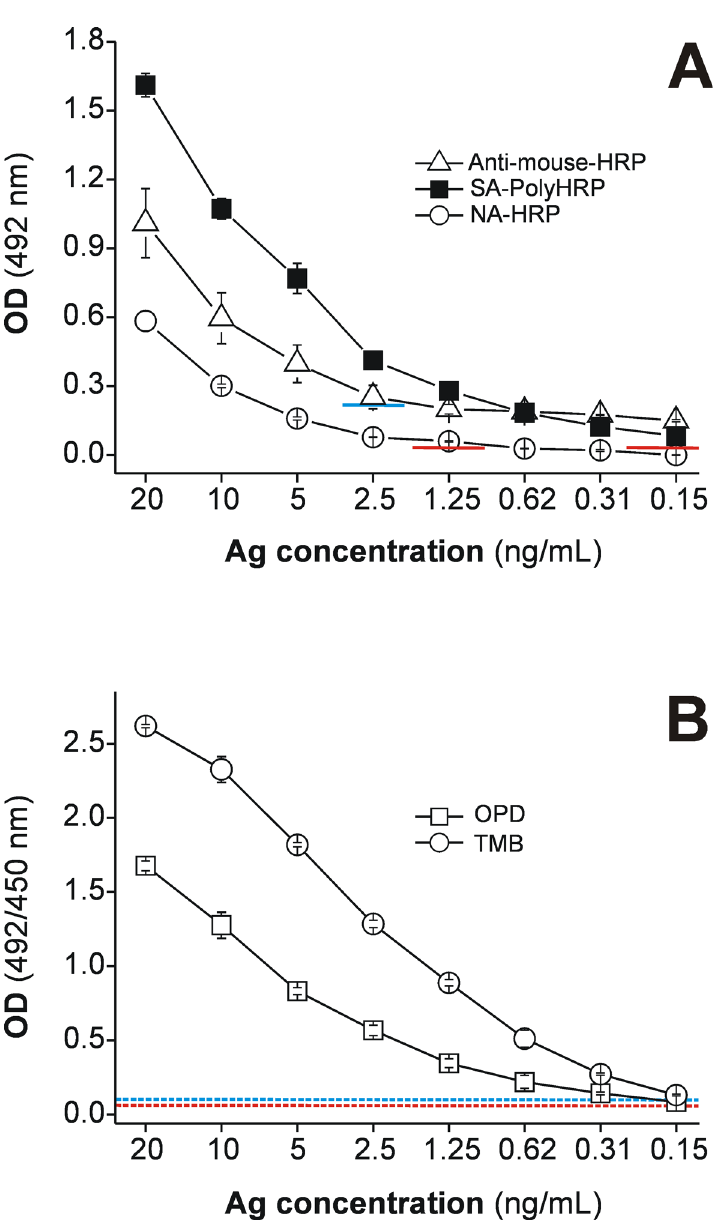
Fig 3. Detectability of rapid MM3-COPRO ELISA performed with three HRP-labeled secondary reagents and two HRP substrates. Two-fold dilutions (0.15 – 20 ng/mL) of Fasciola hepatica excretory- secretory antigens (Ag) diluted in fecal supernatants obtained from pooled negative samples from cattle (prepared with distilled water) were tested under short incubations (30 min, 750 rpm) at RT with (A) HRP- labeled anti-mouse IgG antibodies (triangles; cut-off OD = 0.224, blue line), SA-PolyHRP (squares; cut-off OD = 0.055, red line) and NA-HRP (circles), revealed with OPD substrate; and (B) SA-PolyHRP revealed with two HRP substrates, OPD (squares; cut-off OD = 0.055, dashed red line) and TMB (circles; cut-off OD = 0.084, dashed blue line). were able to correctly classify all samples and the signal-to-noise ratios were optimal for both. Nevertheless, as expected, higher OD values and cut-off values were obtained when SA-Po- lyHRP secondary reagent and the TMB substrate were combined (model C, cut-off